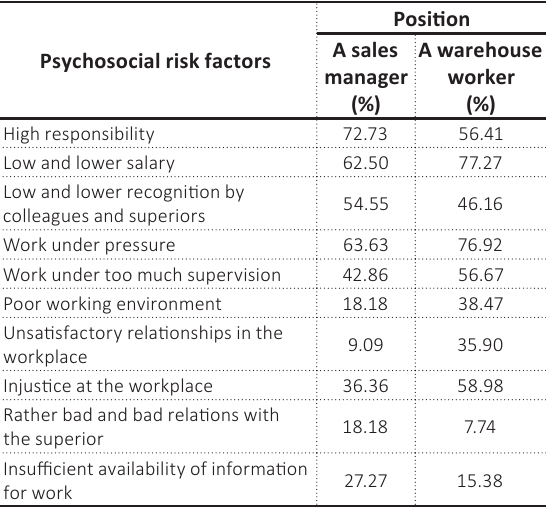
Table 1. Psychosocial risk factors in the company – summary